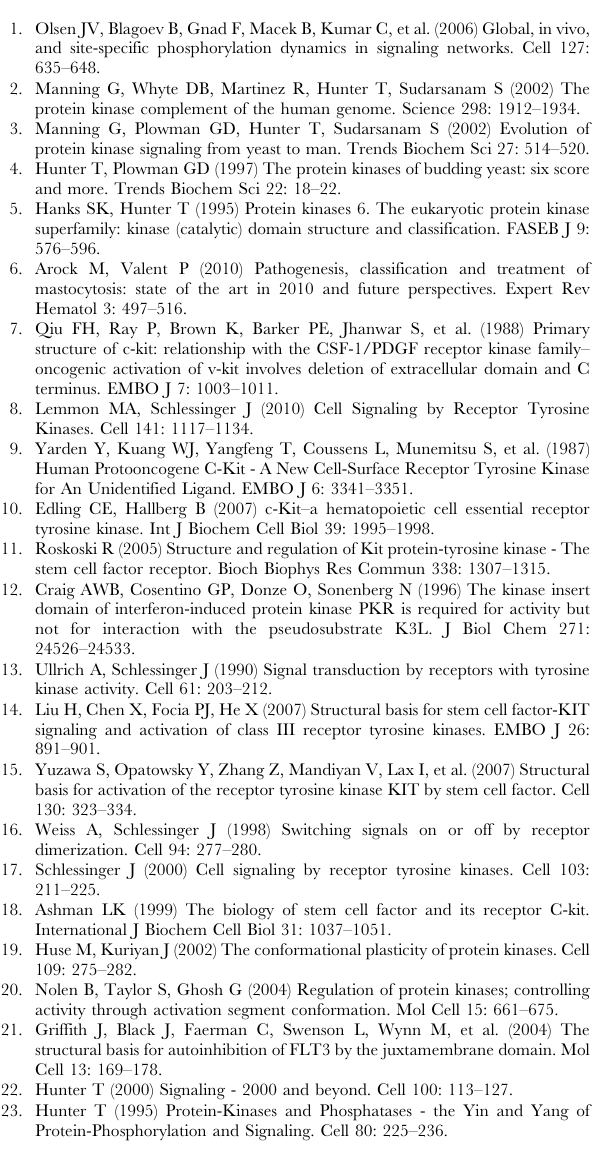
backbone atoms of the equilibrated conformations versus the initial template. (PDF) Table S2 RMS deviations (in A˚ ) upon energy minimization calculated on C- a atoms for every MD conformation used for NMA. The value obtained for the structure 1T45 is 1.55 A˚ .